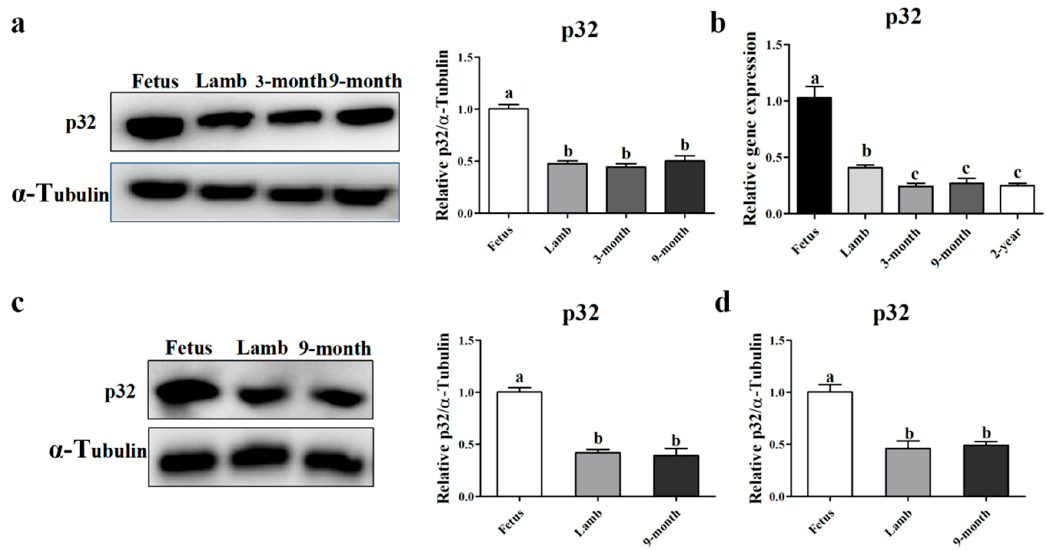
Figure 3. Expression patterns of p32 protein ( a ) in the longissimus muscle of Hu sheep at different developmental stages (fetus, lamb, 3 months old, and 9 months old) were measured by Western blot. Expression of p32 mRNA ( b ) in the longissimus muscle of Hu sheep at different developmental stages (fetus, lamb, 3 months, 9 months, and 2 years) were measured by qRT-PCR. Expression patterns of the p32 protein ( c ) and mRNA ( d ) in the quadriceps muscle of sheep at three different developmental stages (fetus, lamb, and 9-month) were measured by qRT-PCR and Western blot, respectively. Expressions of the gene were normalized to glyceraldehyde-3-phosphate dehydrogenase ( GAPDH ) and related to the fetus. Results are expressed relative to the fetus as mean values ± SEM ( n = 3). a, b, c: different letters denote statistically significant differences within each group; p < 0.05.